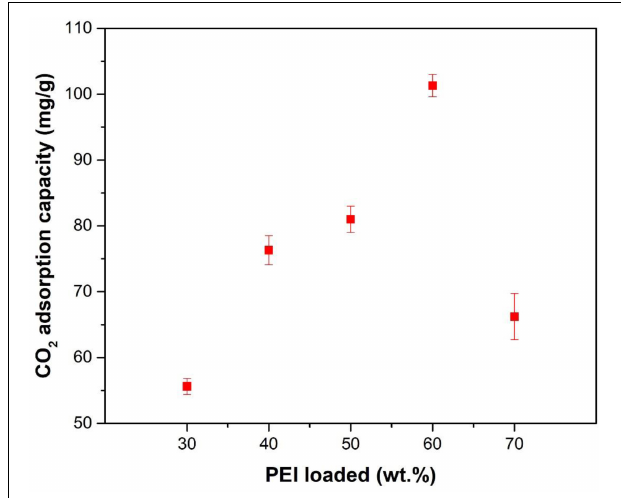
FIGURE 8 | The effect of PEI loading on the CO 2 adsorption capacity at 70 ◦ C and in CO 2 partial pressure of 100 kPa.